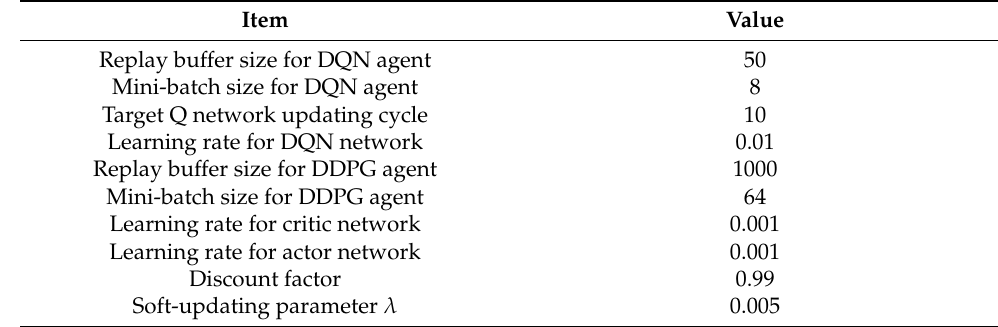
Table 2. Settings of other DRL parameters.